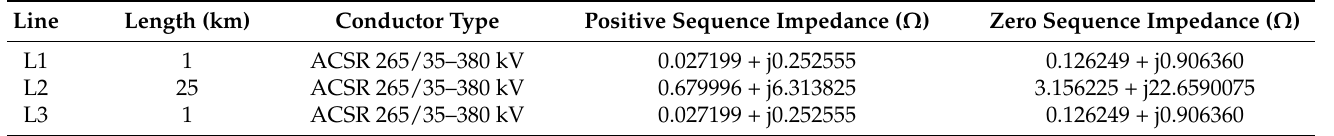
Figure 1. Power system model. Table 1. Transmission line